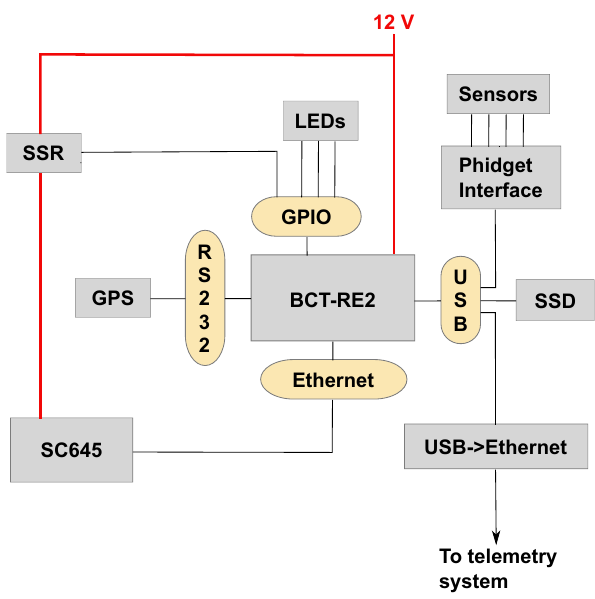
Fig. 2. Block diagram showing the main components of the camera